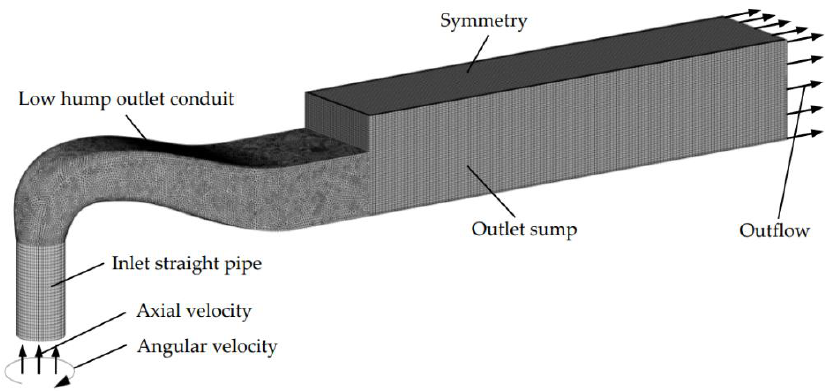
Figure 4. Calculation domain of flow field simulation and mesh generation.